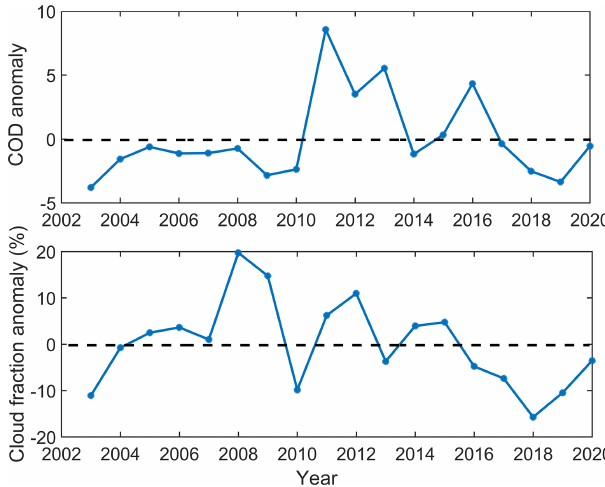
Figure 10. The monthly cloud optical depth (COD) anomaly and cloud fraction anomaly at Brisbane Archerfield during January from 2003 to